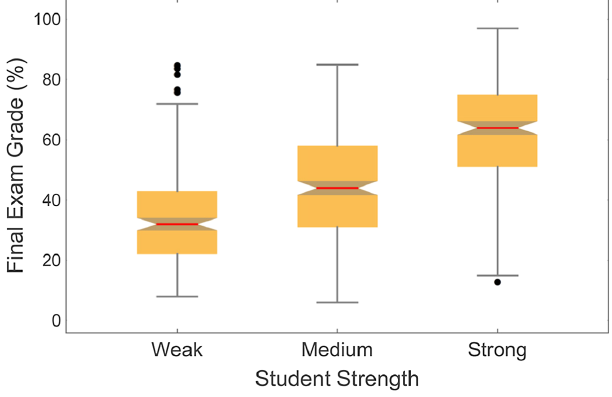
FIG. 2. Box plots of final examination grades for different student strengths as measured by their precourse FCI scores.